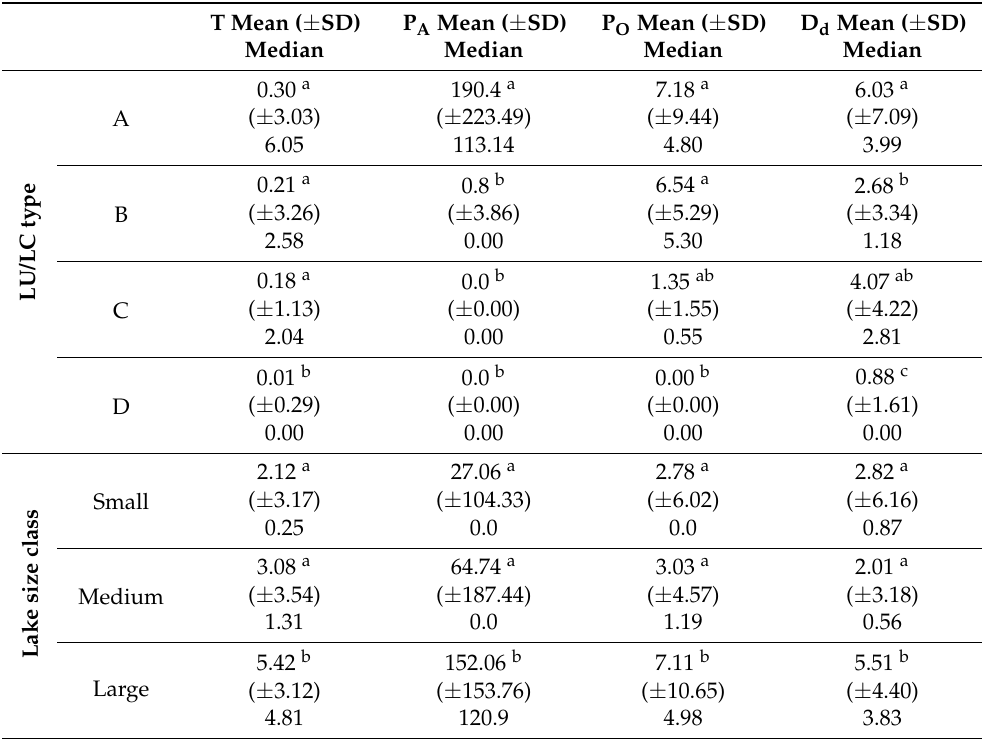
Table 4. Tourism impact indices for the LU/LC types of the lakeshore zones and the size classes of the